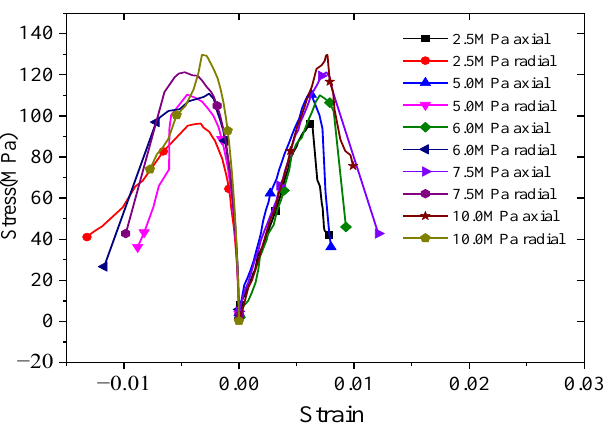
Figure 14. Relationship between the stress and strain of sandstone under triaxial compression tests. Table 3. The axial compressive strength under different confining pressures.